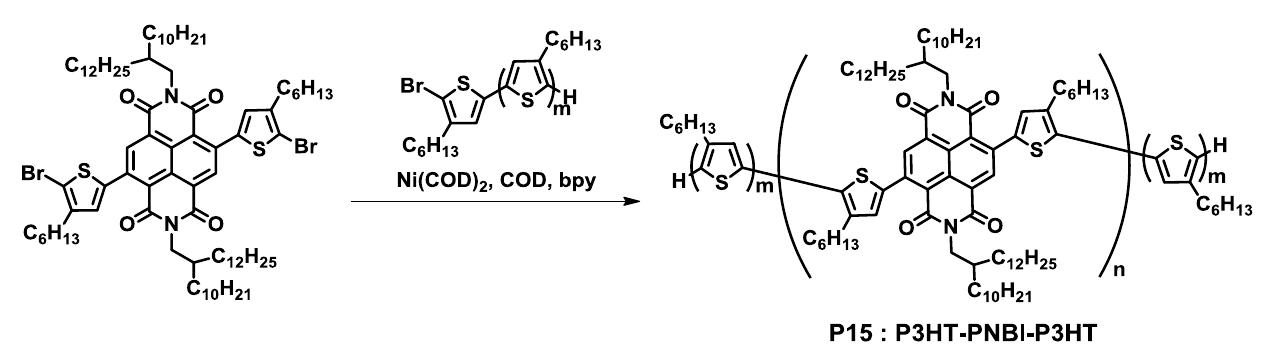
Figure 12. Synthesis of P15